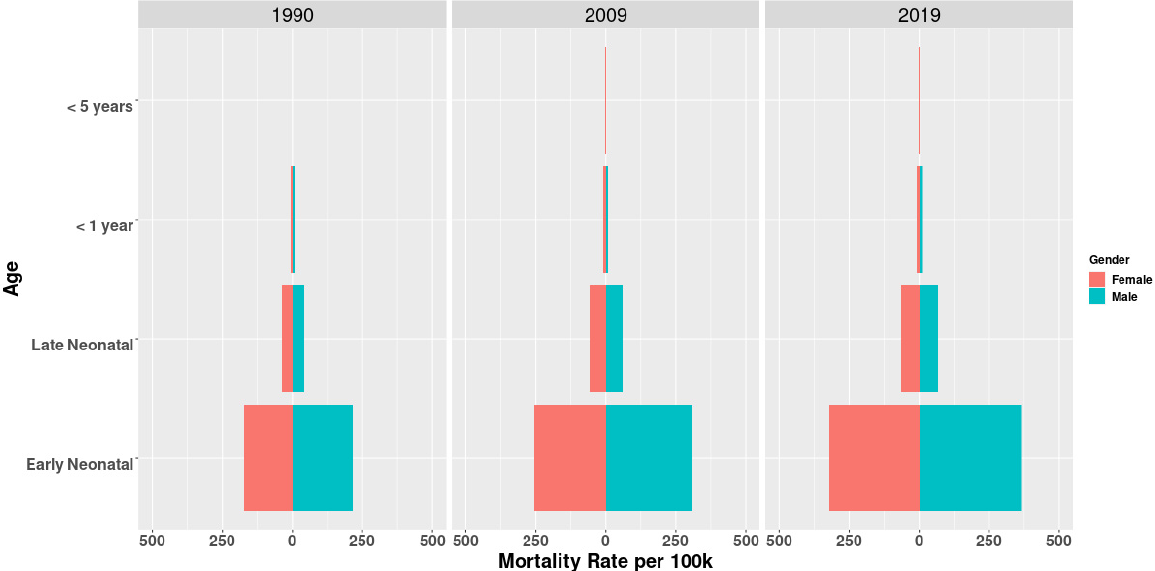
Figure 3. Global mortality rates (per 100 thousand) in different age groups and genders for PM2.5- related neonatal infections in ( a ) 1990, ( b ) 2009, and ( c ) 2019.